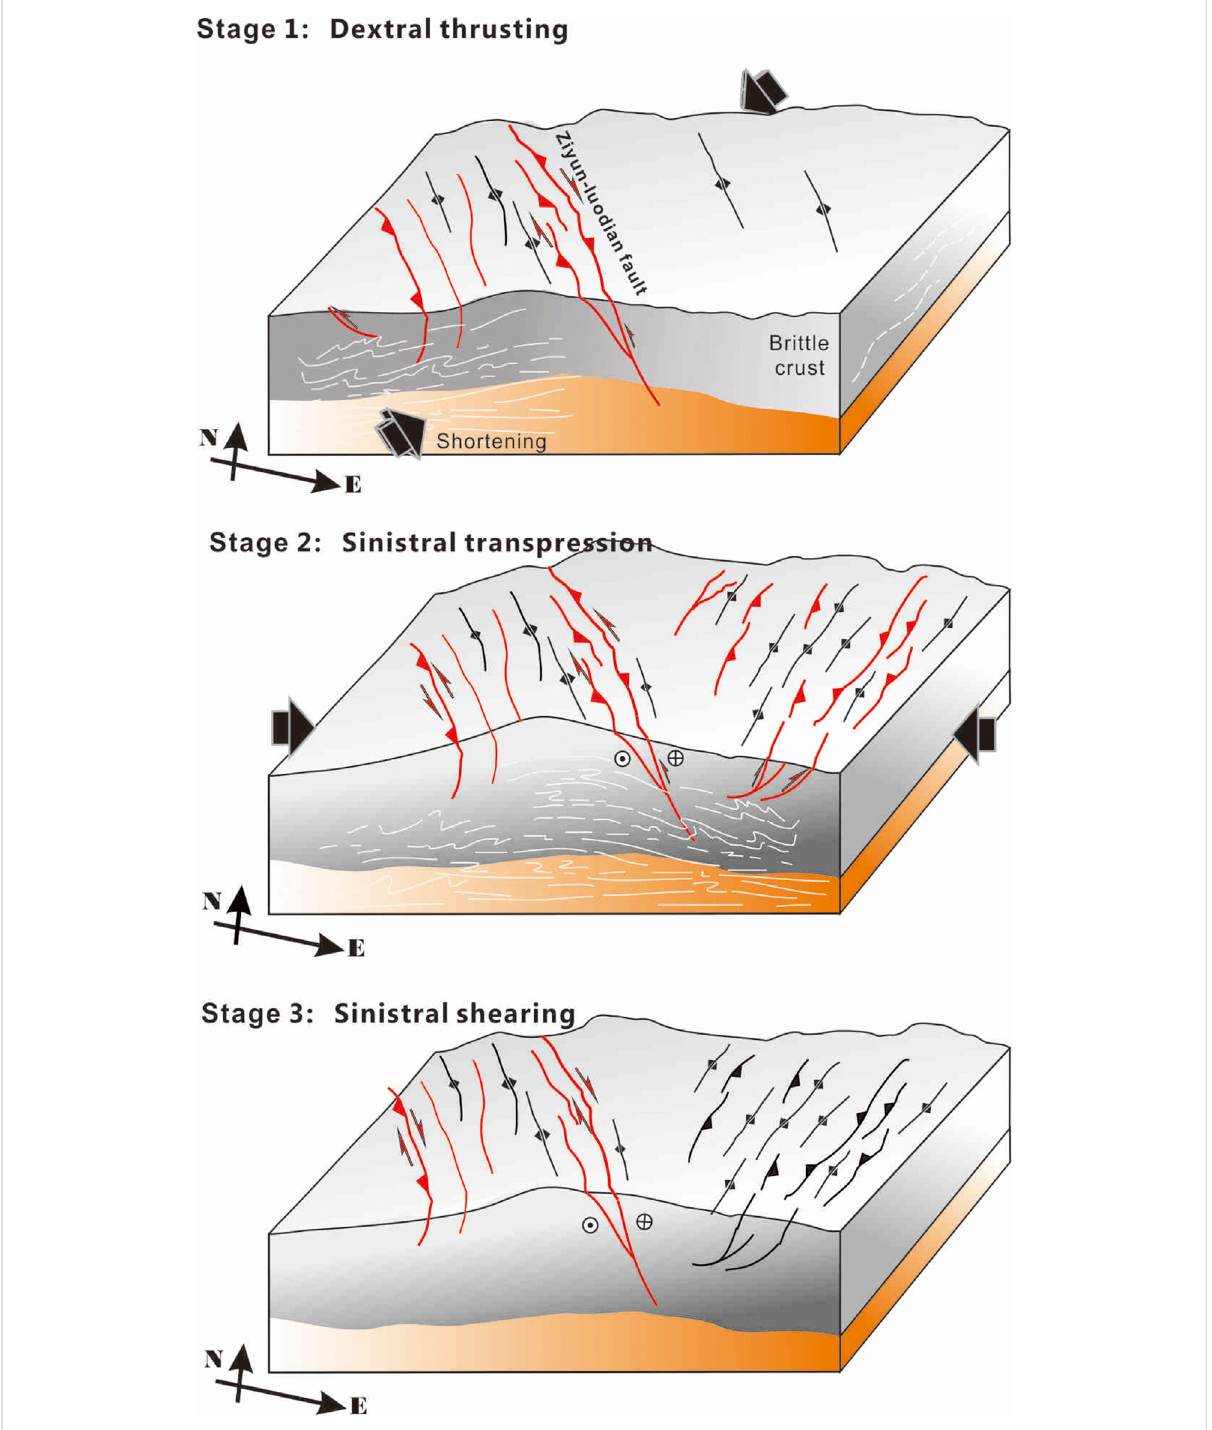
TectonicmodeloftheZiyun-LuodianfaultandtheGuizhouProvinceduringtheMeso-Cenozoic.Atleastthreestagesofdeformationincluding dextral thrusting, sinistral transpression, and sinistral strike-slip movement have been recognized along the ZLF in the